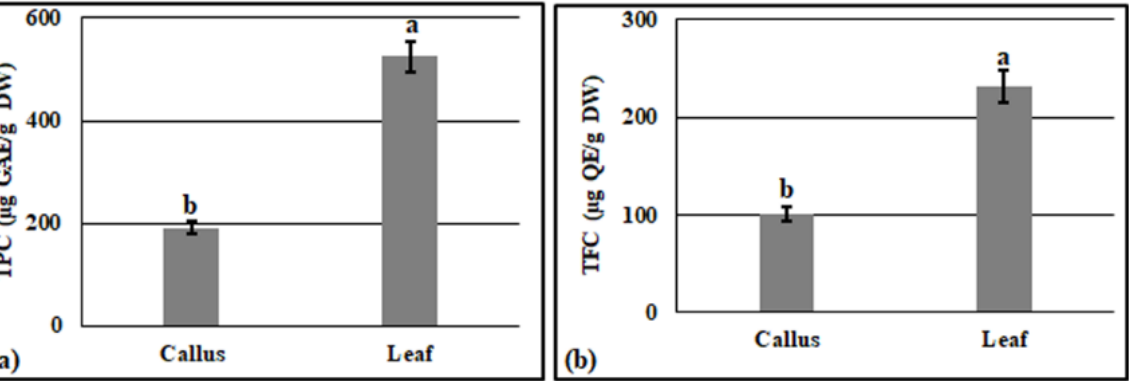
Figure 4. Total phenolic content expressed as gallic acid equivalent ( a ) and total flavonoid content expressed as quercetin equivalent ( b ). Values are the mean of three replicates ± S.D. Letters a and b on bars indicate the significant differences according to Duncan’s test ( p < 0 : 05).